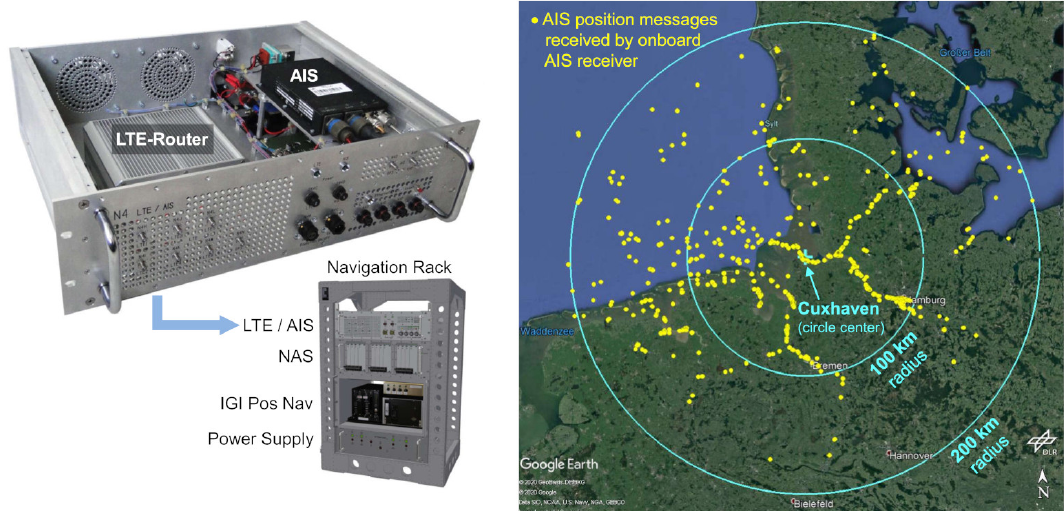
Figure 12. Onboard AIS dual-channel receiver and LTE router for data transfer to ground ( left ) and AIS signals received during a flight campaign conducted in the North Sea around Cuxhaven in November 2019 ( right ). During a single flight track with a radar acquisition of 70 s duration a number of 1497 AIS position messages (yellow dots) was received from ships with distances up to 200 km far